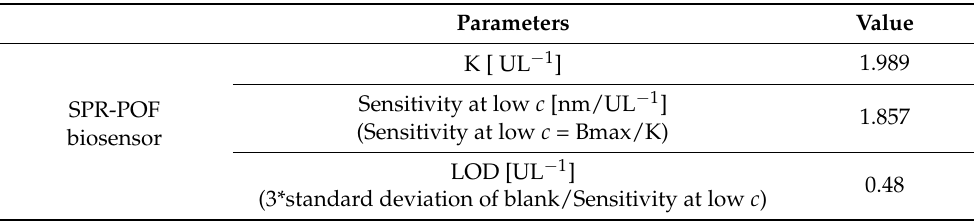
Table 3. Chemical parameters for amylase detection in real samples by SPR-POF biosensor.